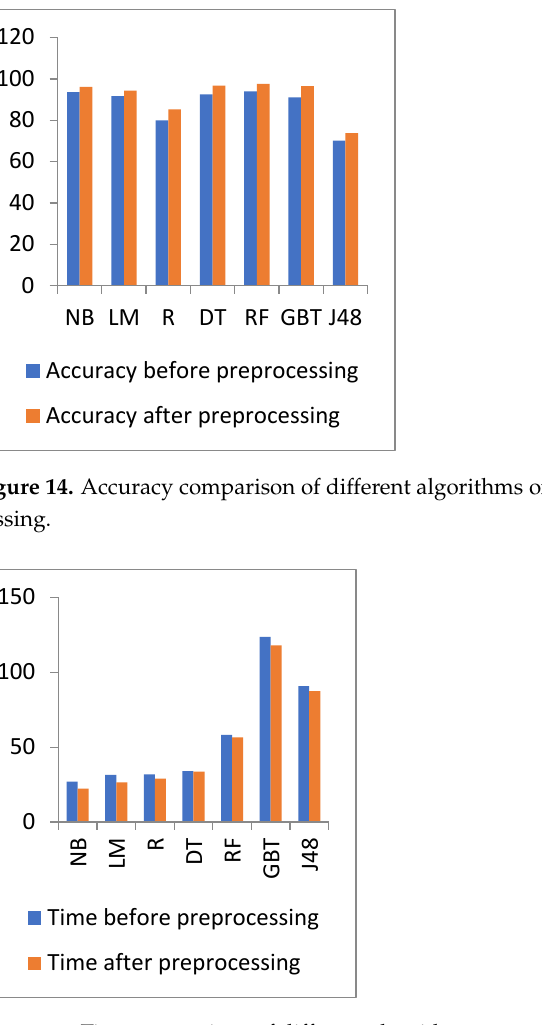
Figure 13. The SD values of diabetes disease data.